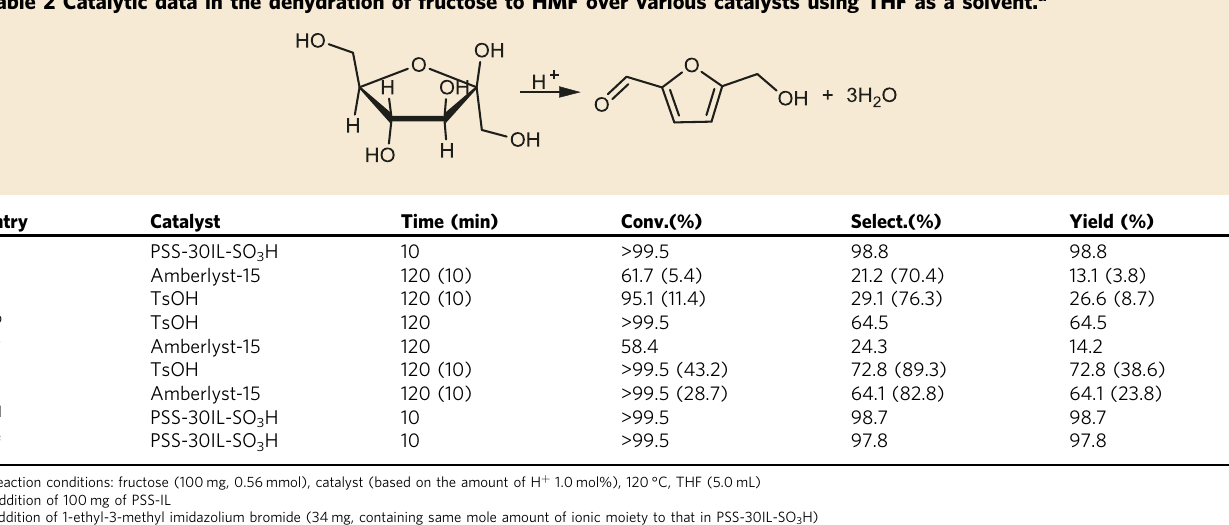
Table 2 Catalytic data in the dehydration of fructose to HMF over various catalysts using THF as a solvent.